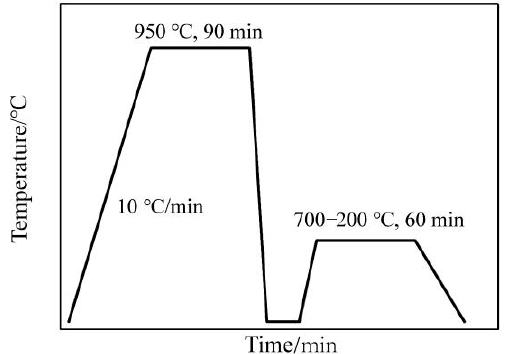
Figure 2. Thermal solving and aging process of